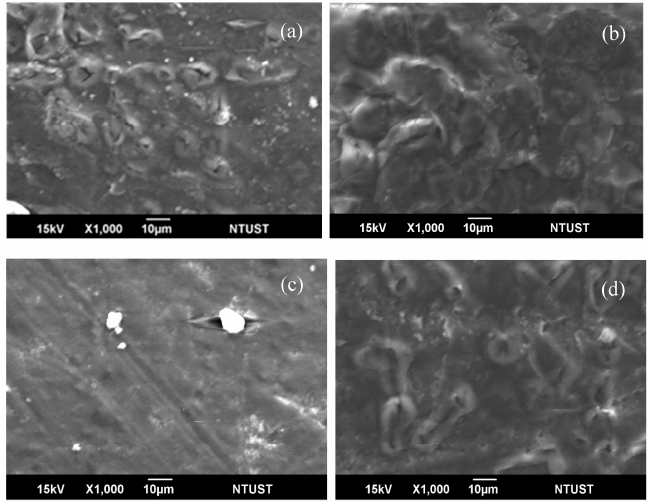
Figure 10. Weight loss of ( a ) PLA; ( b ) PLA/MWCNT-Ag 0.1 ; ( c ) PLA/MWCNT-Ag 0.2 ; and ( d ) PLA/MWCNT-Ag 0.3 nanocomposites.